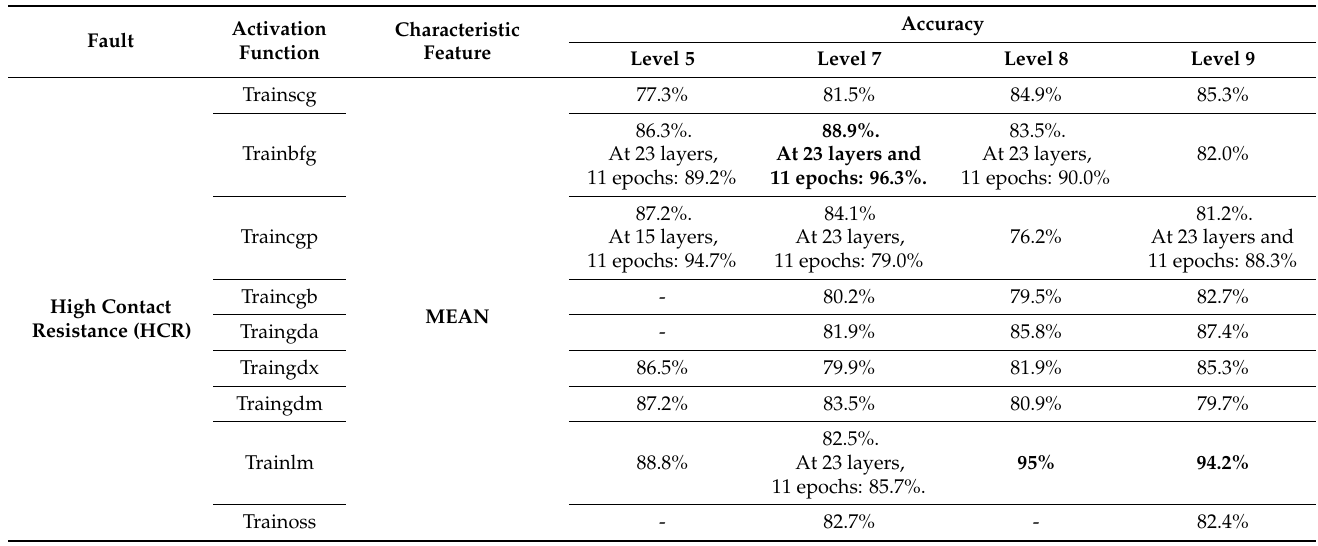
Table 5. High Contact Resistance Fault with Mean Feature Accuracies under different Activation Functions.